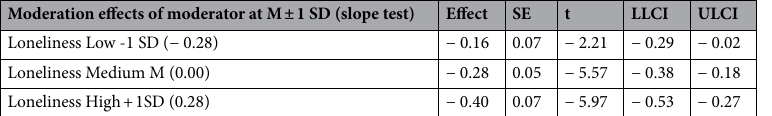
Moderation effects of moderator at M ± 1 SD (slope test) Effect